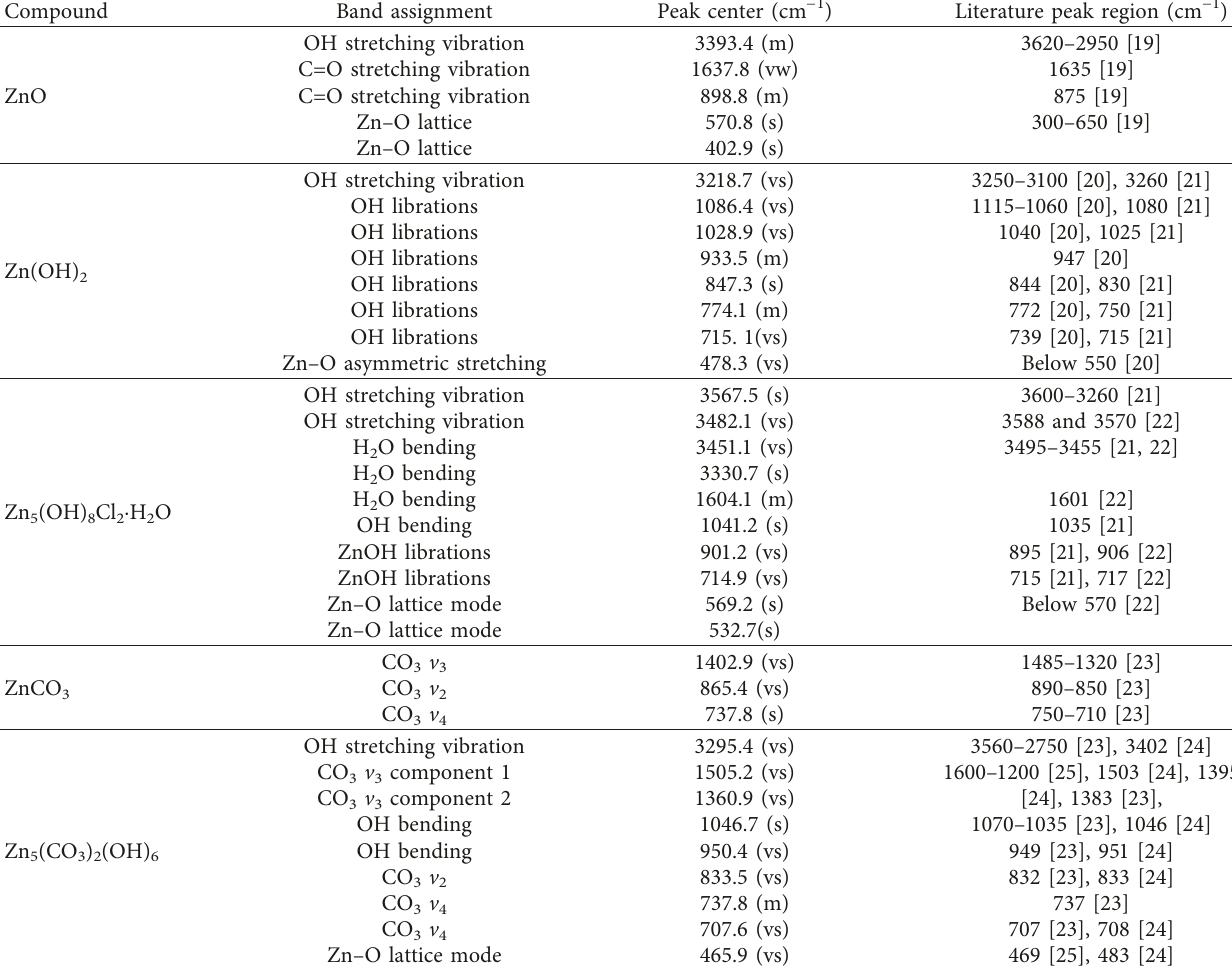
Table 1: Results of FT-IR ATR spectra for the synthetic products of zinc corrosion: ZnO, Zn(OH) Zn 5 (CO 3 ) 2 (OH) 6